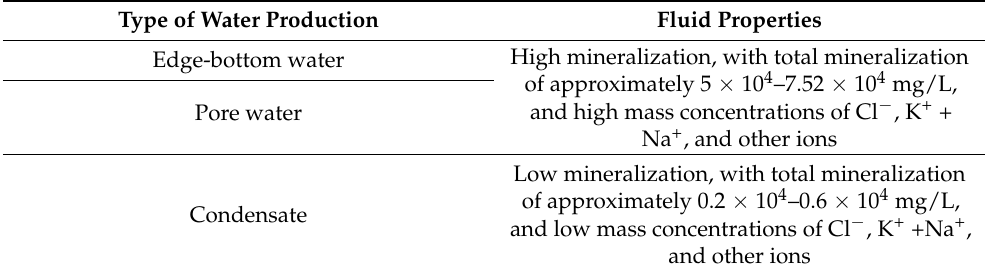
Table 1. Physical characteristics of effluent.